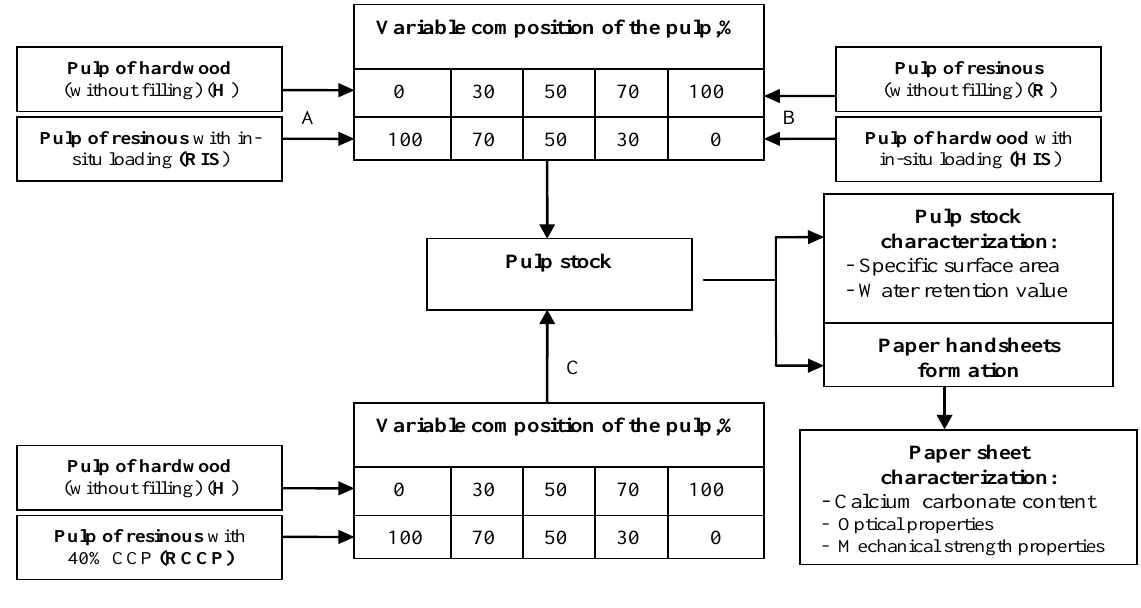
Figure 1. Experimental program for the three series of pulp with different composition.